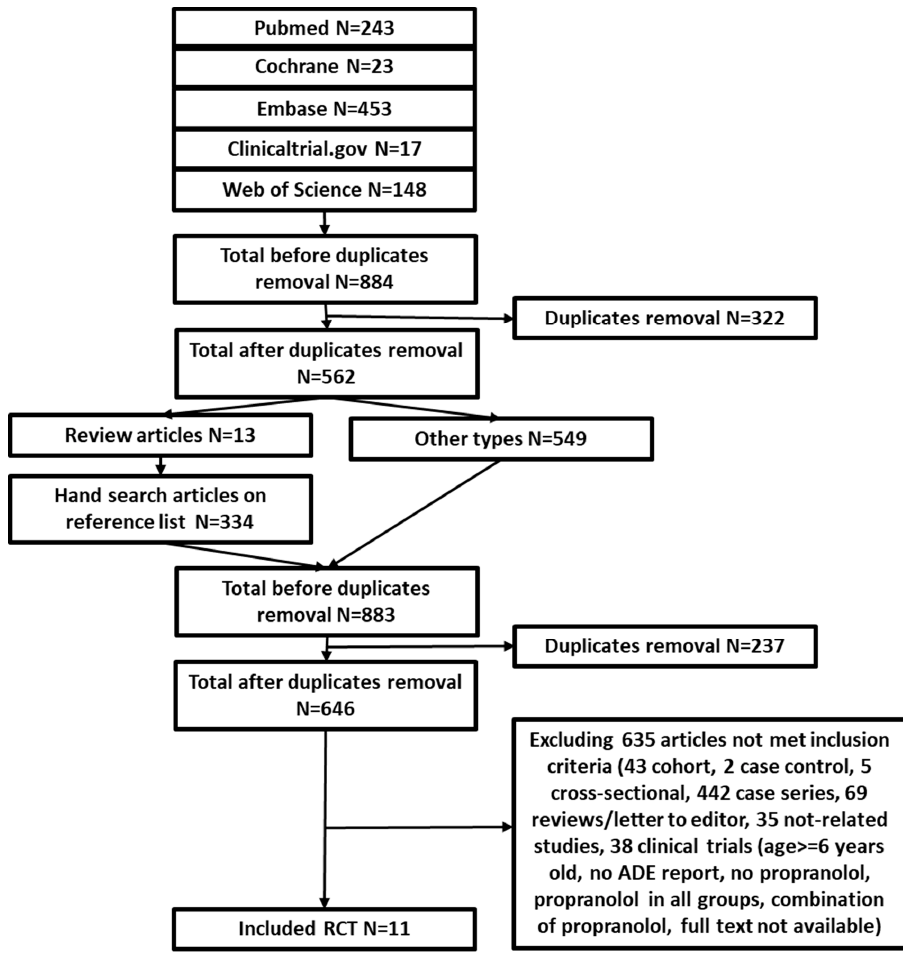
Figure 1. PRISMA diagram for study selection.